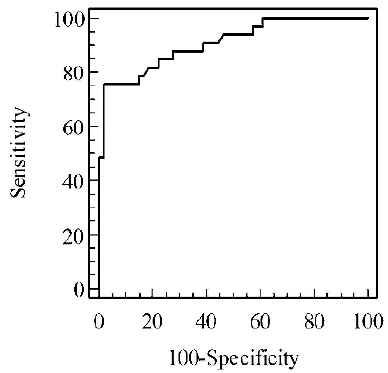
Figure 2 - Receiver operating characteristic curve of SOD2 for the differential diagnosis of TPEs and MPEs. The area under the curve was 0.909 (95%CI: 0.827-0.960).